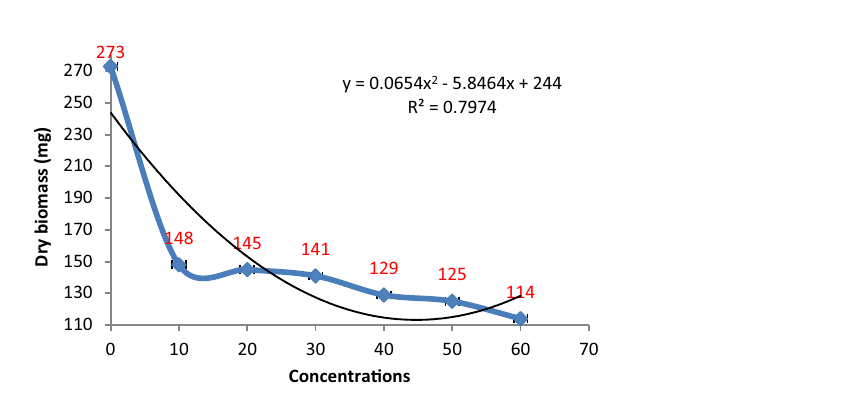
Figure 6. Effect of different metabolite concentrations of P. verrucosum on the biomass production of P. herbarum. Vertical bars show standard errors of the means of three